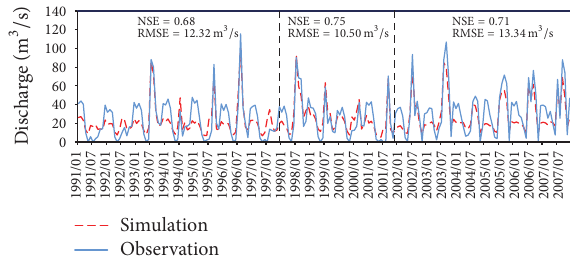
Figure 6: 1991–2007 simulated and observed monthly discharge at the Zhengyixia.